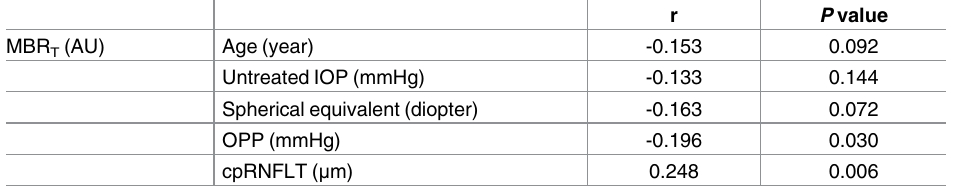
Table 3. Relationship between ocular blood flow and patient background parameter at baseline in preperimetric glaucoma